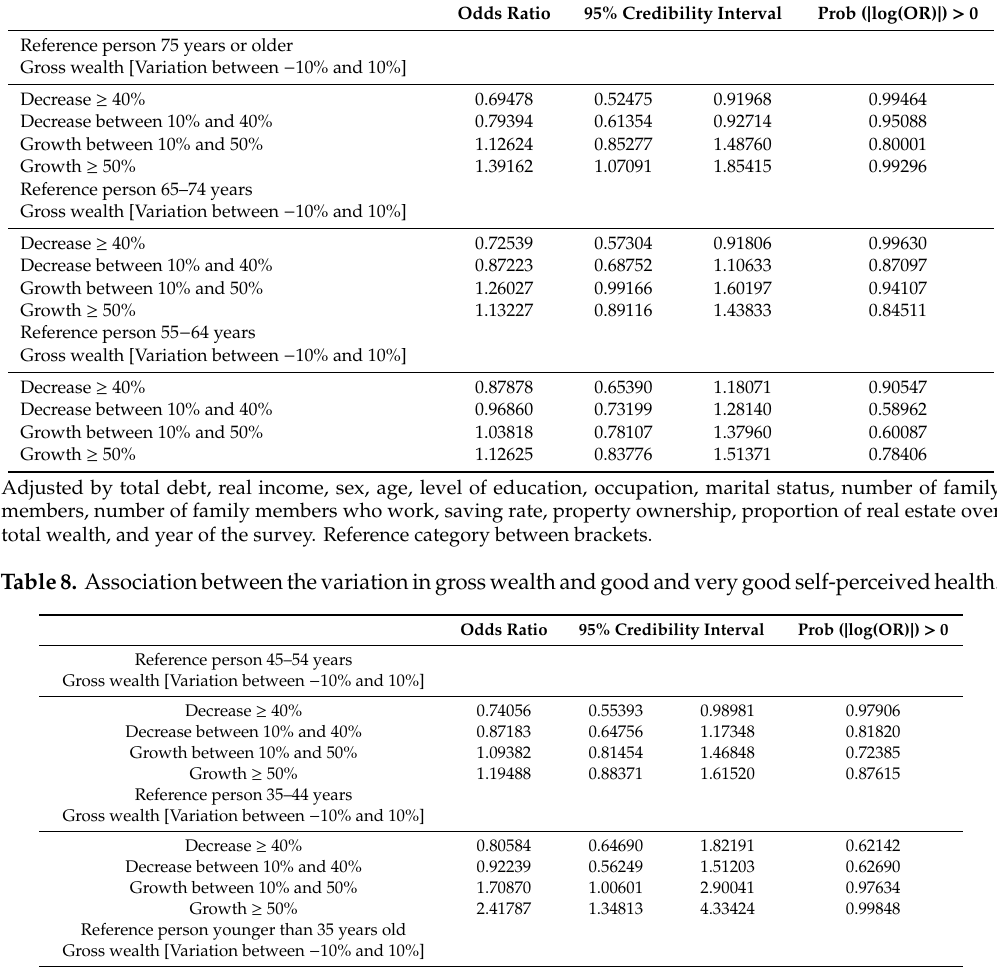
Odds Ratio 95% Credibility Interval Prob ( | log(OR) | ) > 0